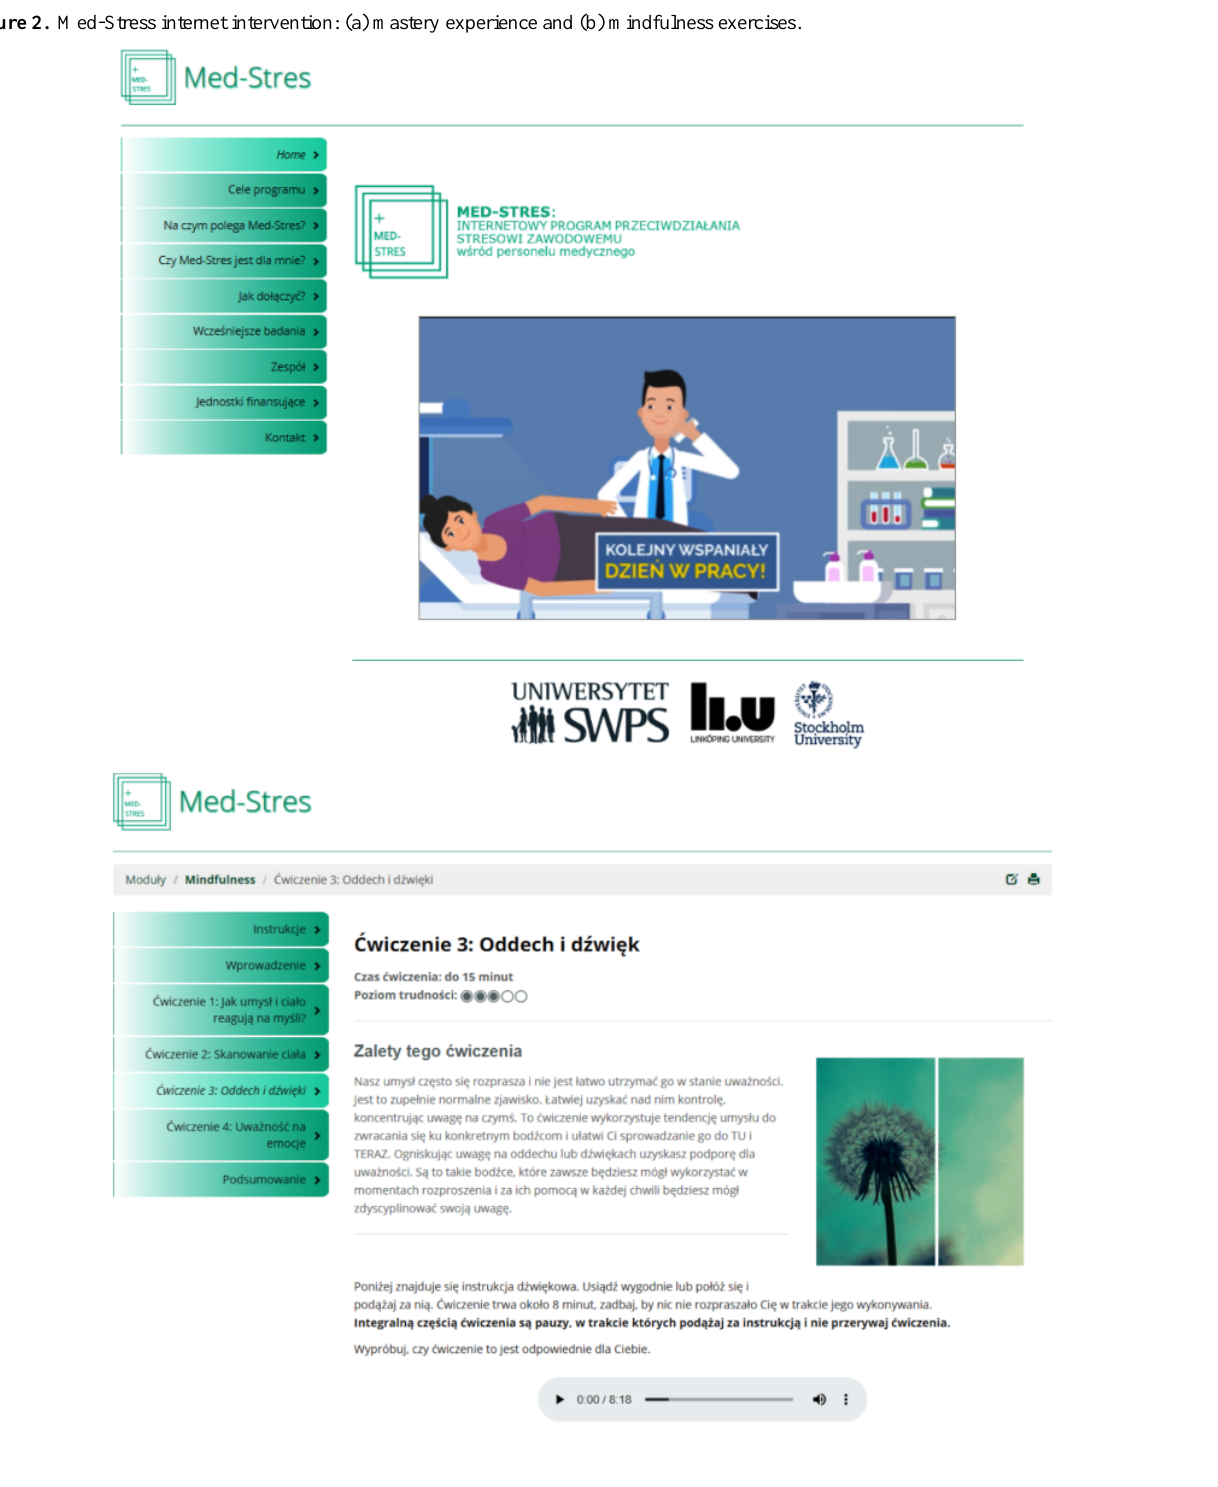
Figure 2. Med-Stress internet intervention: (a) mastery experience and (b) mindfulness exercises.